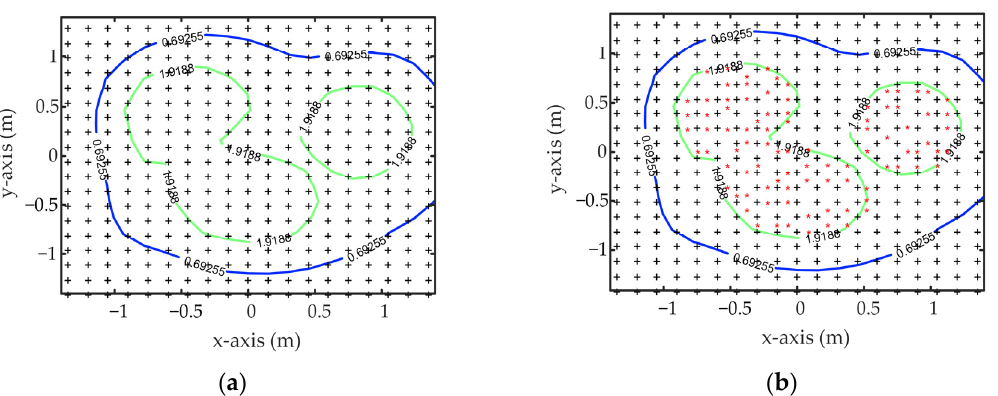
Figure 12. The distribution of measuring points. ( a ) Before the additional measurement; ( b ) After the additional measurement.